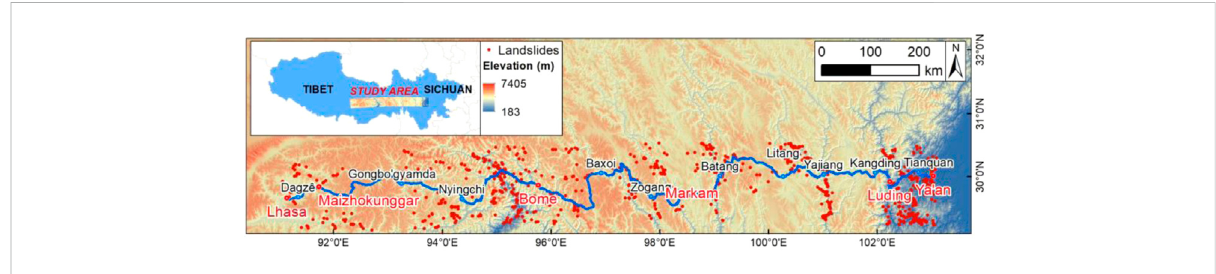
FIGURE 1 Historical landslide inventory and the Sichuan-Tibet Highway